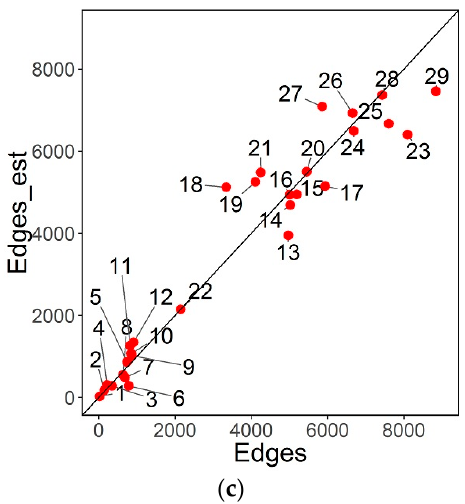
Figure 5. Estimation of ( a ) average degree ( b ) average betweenness ( c ) number of edges.